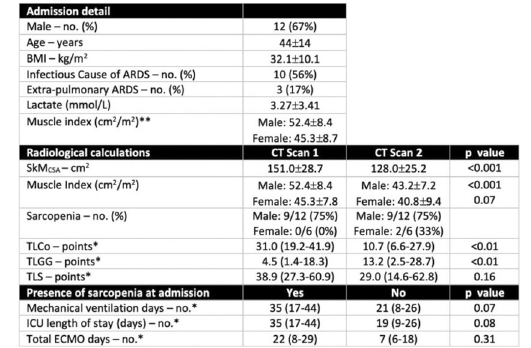
Table 1 (abstract 000958). See text for